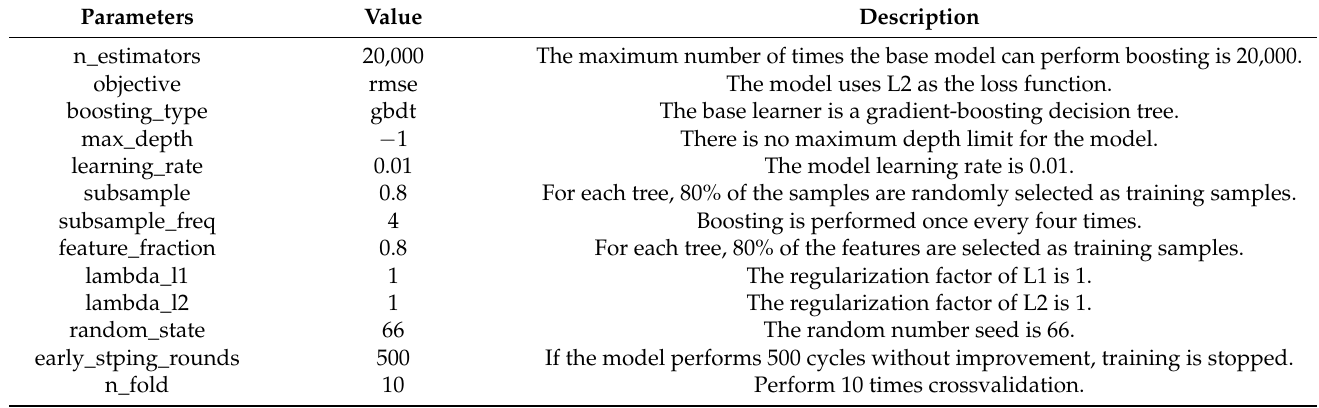
Table 2. LightGBM parameter settings.